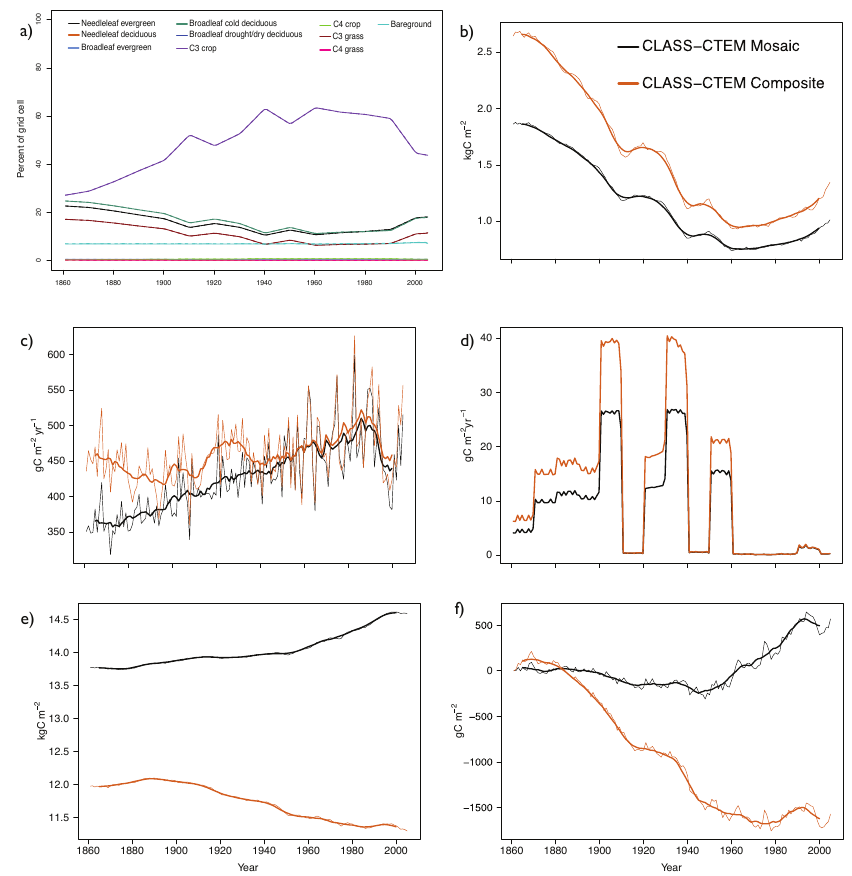
Fig. 8. CLASS-CTEM results for the mosaic and composite approaches for a grid cell at 50.10 ◦ N and 46.88 ◦ E (near Volgograd, Russia) from the Climate + CO 2 + LUC simulation. (a) Specified changes in PFT fractional cover, (b) vegetation biomass, (c) net primary productivity (NPP), (d) total deforested biomass as a result of LUC, (e) soil C pool, and (f) total cumulative NBP ( ˜ F L ). The model outputs have a 10yr running mean (thick lines) applied to the annual values (thin lines)